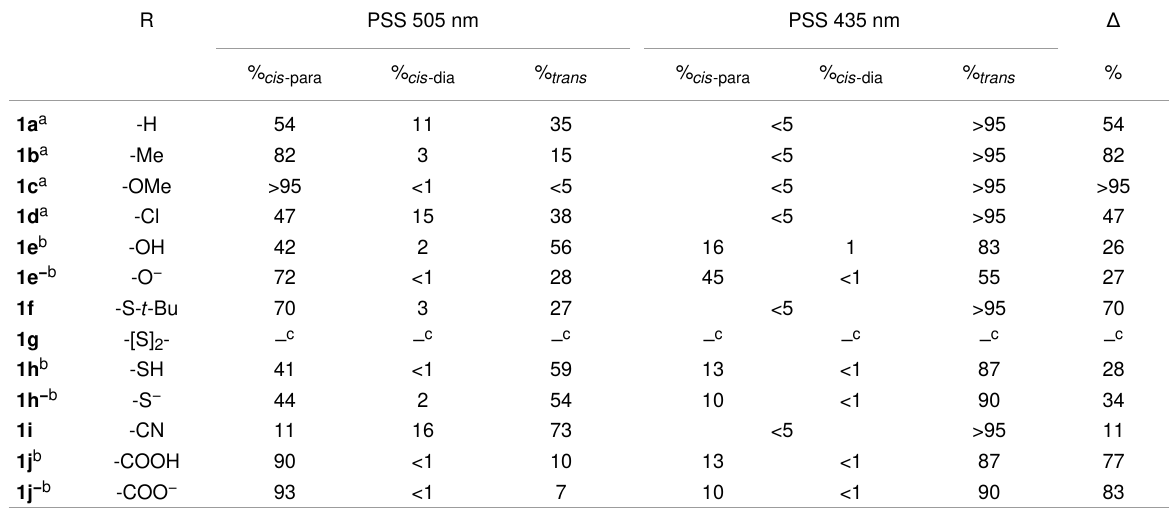
a Recalculated from Dommaschk et al. [4], b determined by UV–vis spectroscopy, c not determined because of very strong intramolecular coordination (Supporting Information File 1, Figure S17).